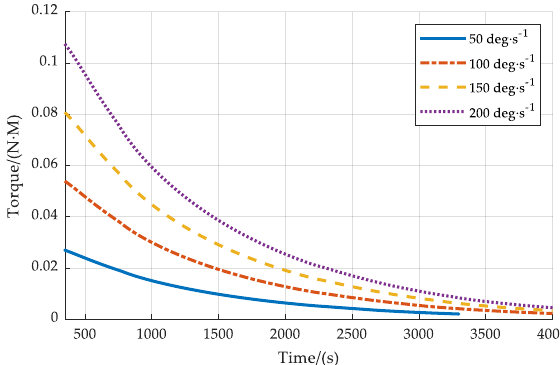
Figure 19. Torque curve of conventional eddy current brake with different initial conditions.